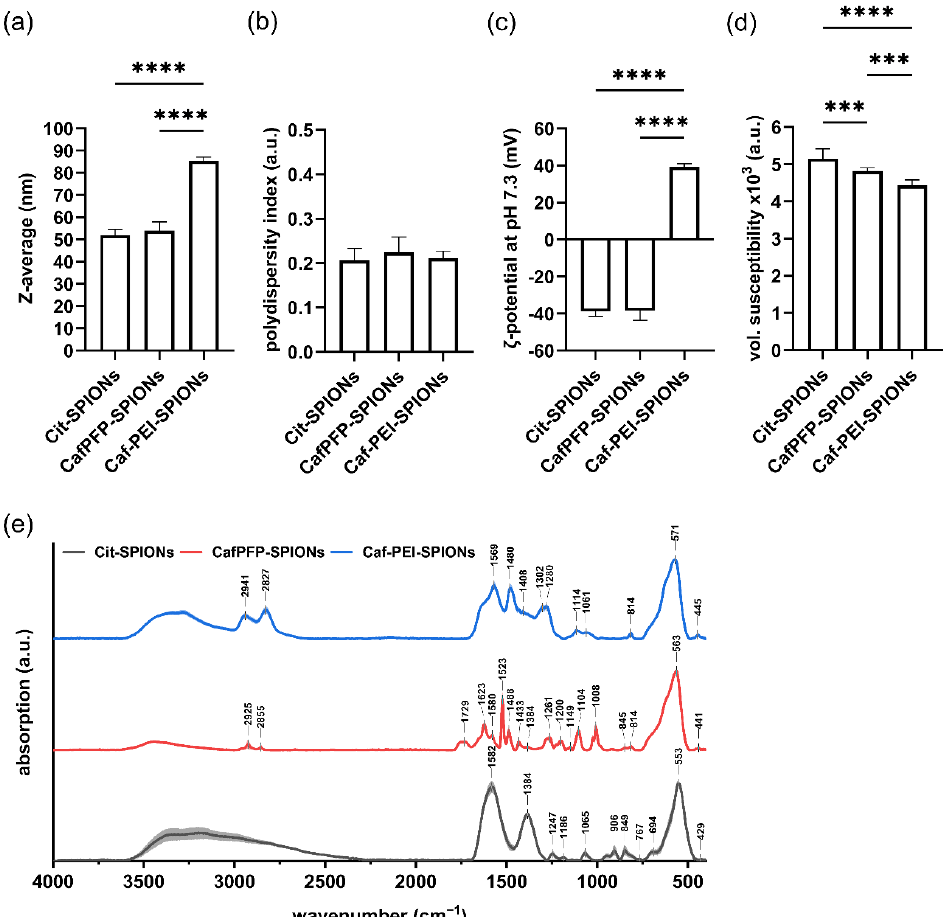
Figure 1. Physicochemical characterization of Cit-, CafPFP- and Caf-PEI-SPIONs. Surface